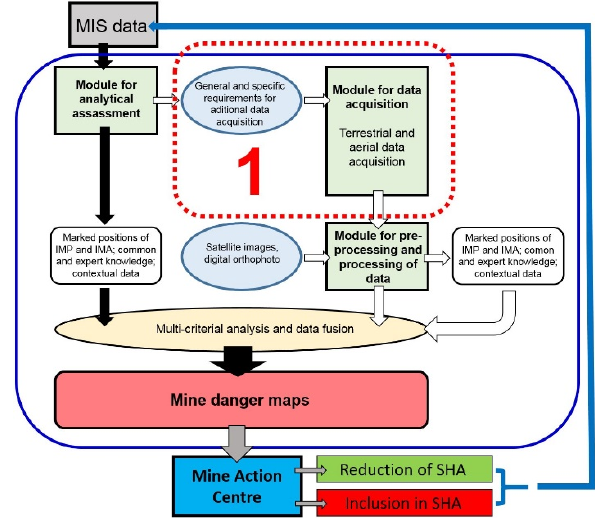
Figure 1. Scheme of Advanced Intelligence Decision Support System (AIDSS) methodology. 1—Module and requirements for data acquisition.